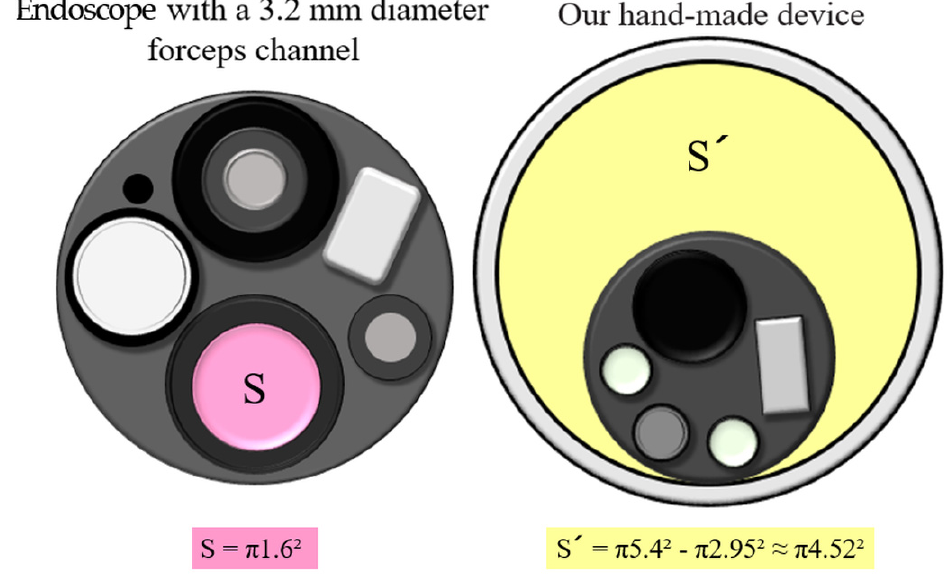
Figure 10. Comparison of suction area (S) with the standard endoscope and (S’) our hand-made device.